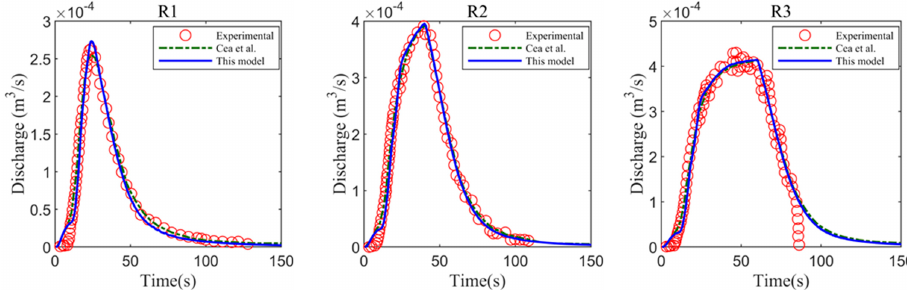
Figure 9. Urban rainfall-runoff experiment: mesh and representation of buildings (partial area). The blue color represents the normal sides, and the red color represent the building sides.